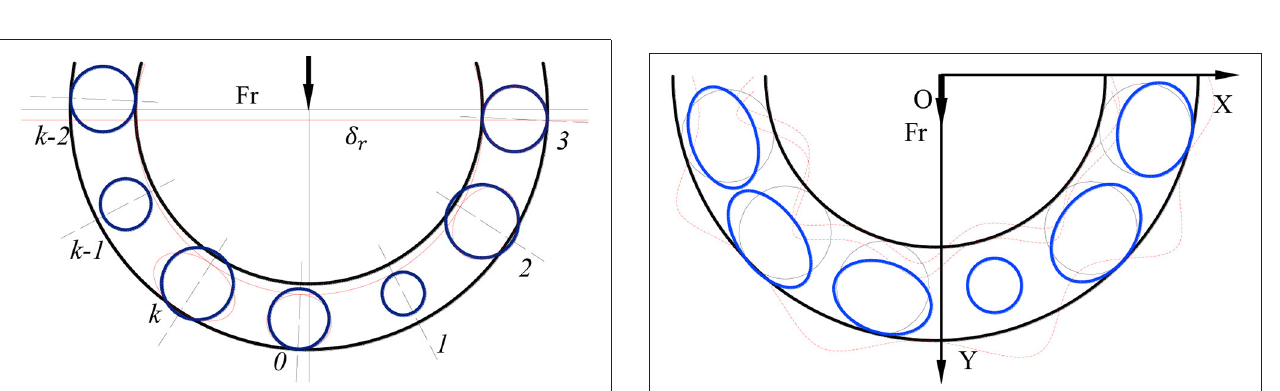
FIGURE 3 | Mechanics analysis with considering ball size error.